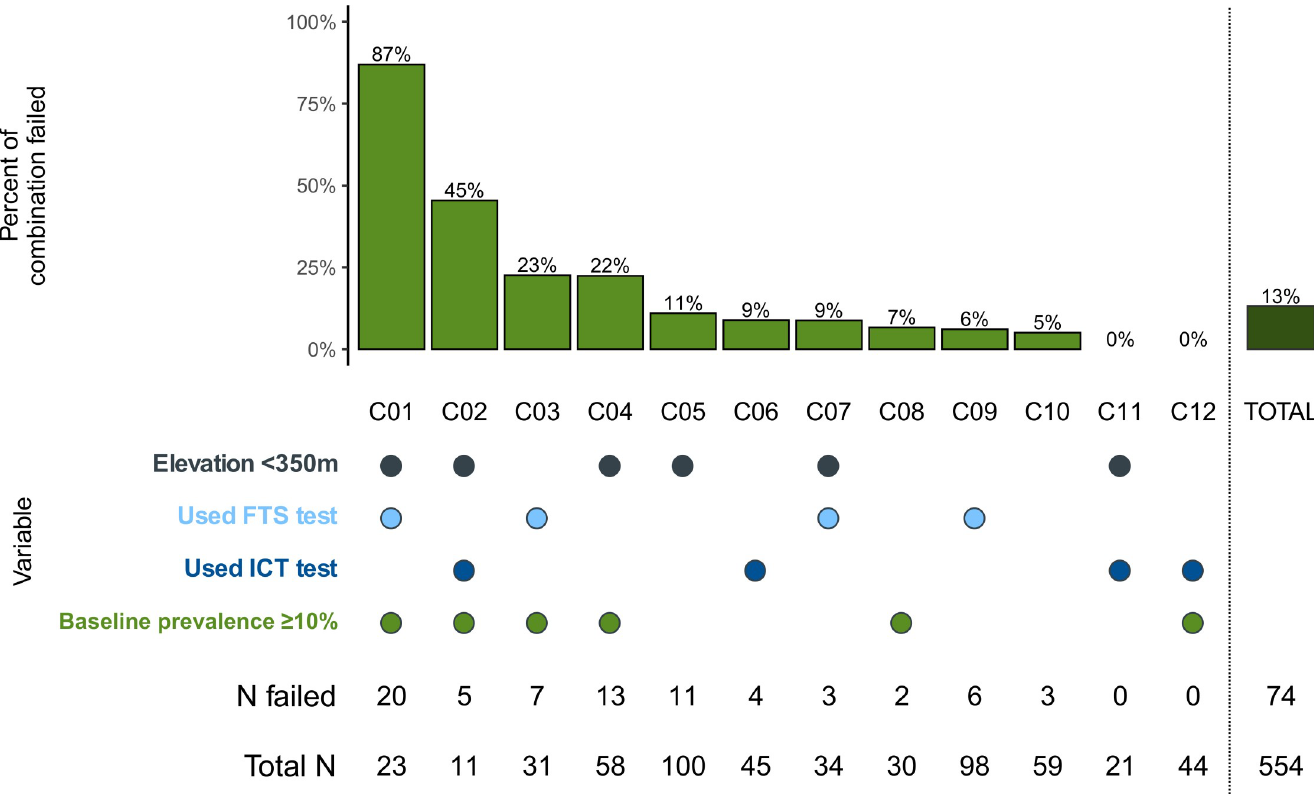
Fig 5. Analysis of failures by model